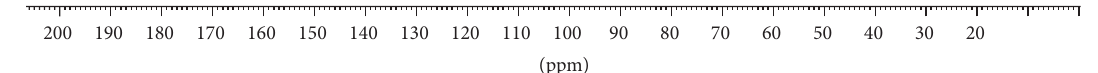
Figure 8: 13 C NMR spectrum of compound (2) in (100MHz, DMSO- d6 ).